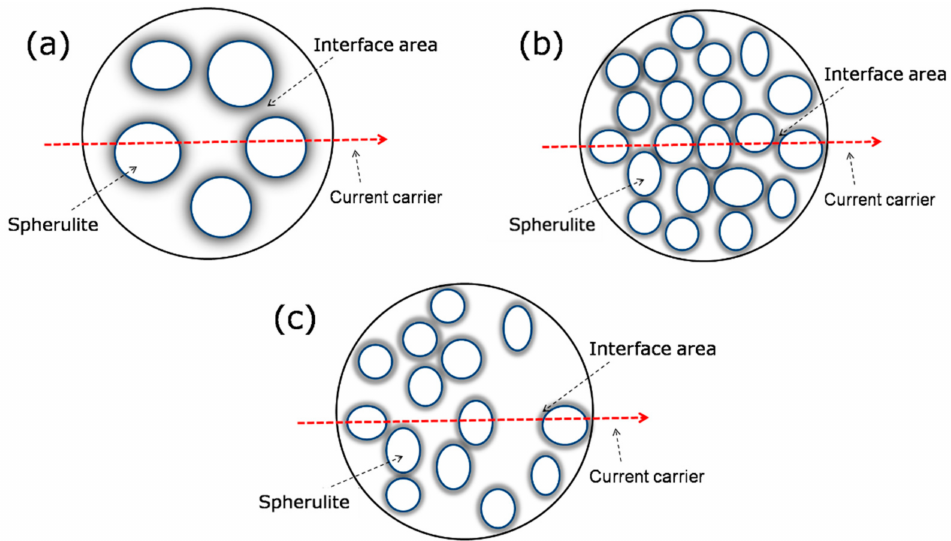
Figure 7. Charge motion under different crystallization conditions. ( a ) When the crystal size is large. ( b ) When the crystal size is small and the crystallinity is significant. ( c ) When the crystal size is small and the crystallinity is